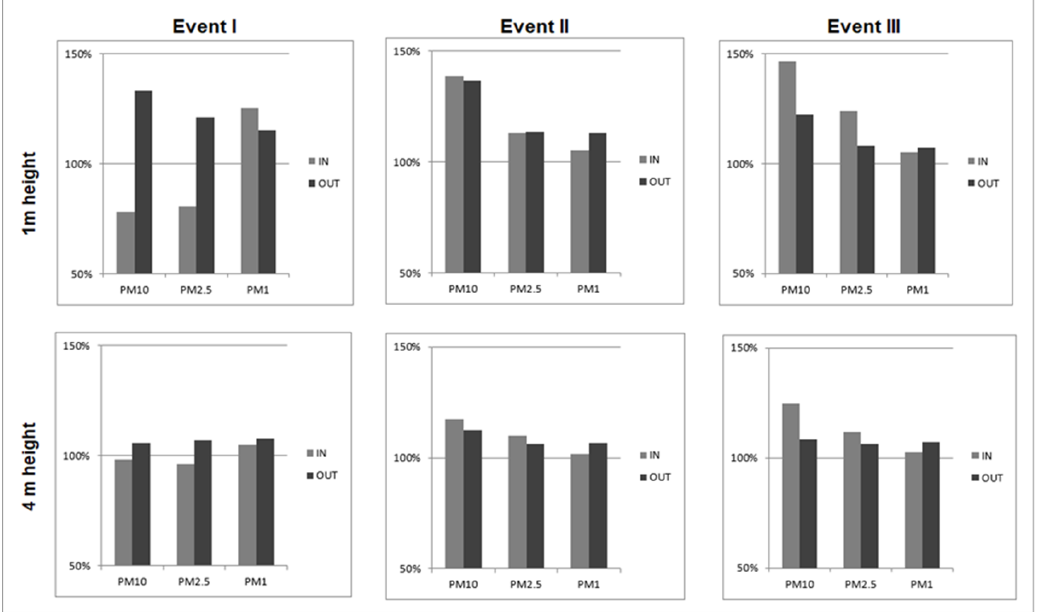
Figure 8. Gust update Efficiency (GuE) for all three events and for the heights of 1 and 4 m, calculated for the three particulate matter classes PM 10 , PM 2.5 , and PM 1 .